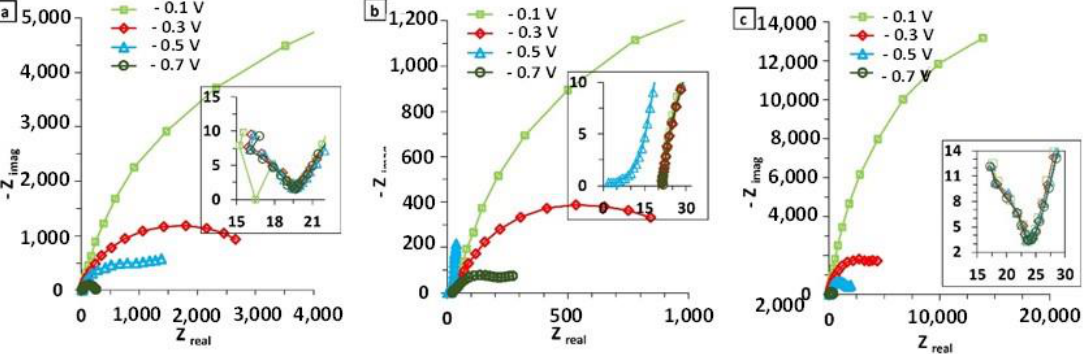
Figure 3. Nyquist diagrams evolution with the potential for ( a ) Al 1.0 , ( b ) Al 0.8 , and ( c ) Al 0.6 . From the Bode-phase spectra in the range −700 to −100 mV (Figure 4) for the three HEAs, the changing of a widely capacitive film to a resistive one can be observed, and this is a measure of the integrity of the film and therefore of the corrosion resistance.